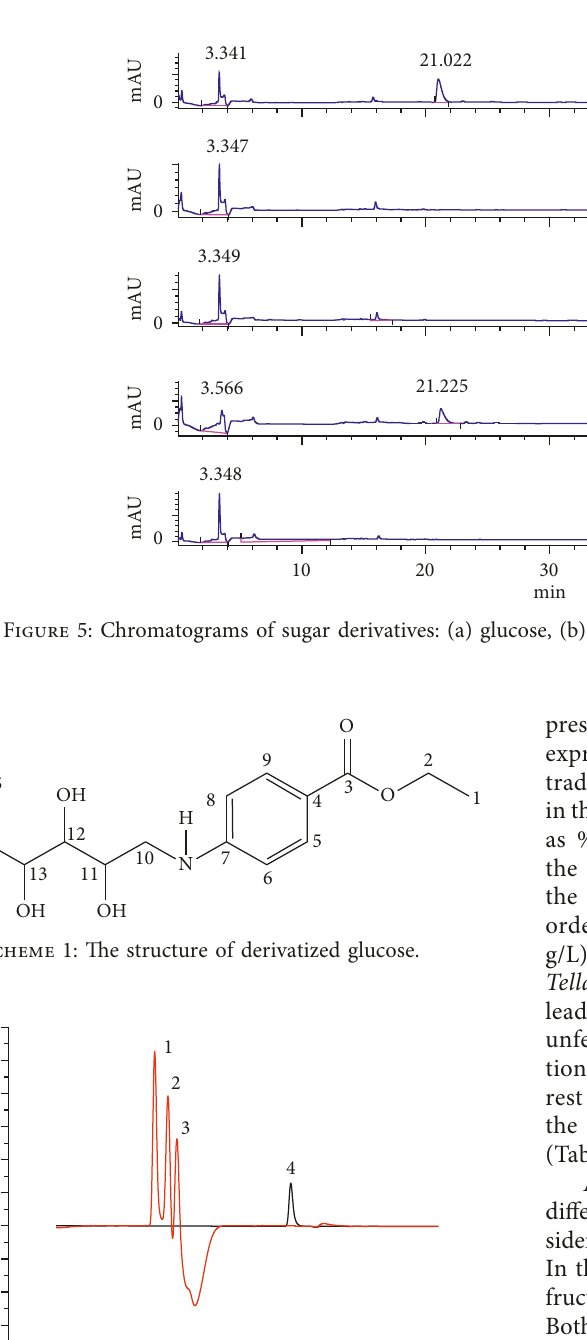
Figure 6: Chromatograms of the mixture of sugars and ethanol: 1 sucrose, 2 glucose, 3 fructose, and 4 ethanol. Column: Hi- (cid:30) (cid:30) (cid:30) (cid:30) Plex H 7.7 300mm ID (35 ° C). Mobile phase: water. Flow rate: × 0.5mL/min. Injection volume: 10 µ